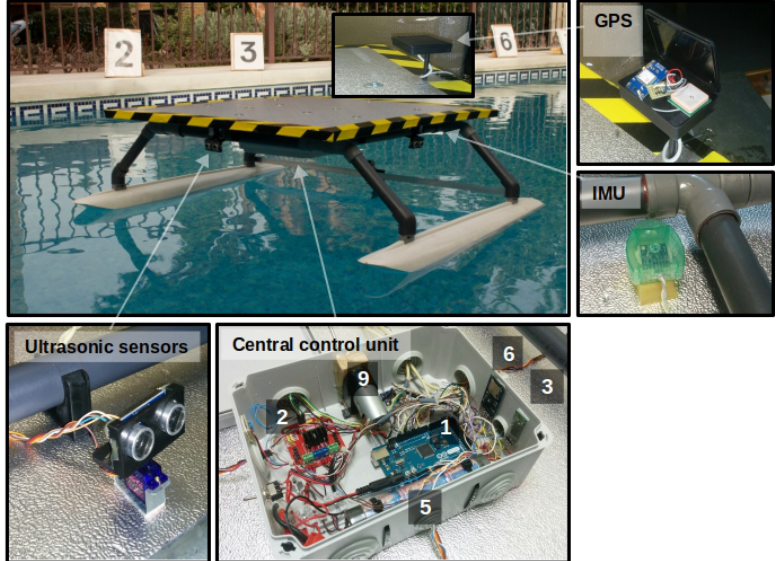
Figure 6. On-board electronics and embedded system. The watertight box with the central control unit was placed in the under the landing pad. The enumerated elements in the figure list the on-board elements present in the system. The GPS was placed in the top of the platform, while the compass was placed